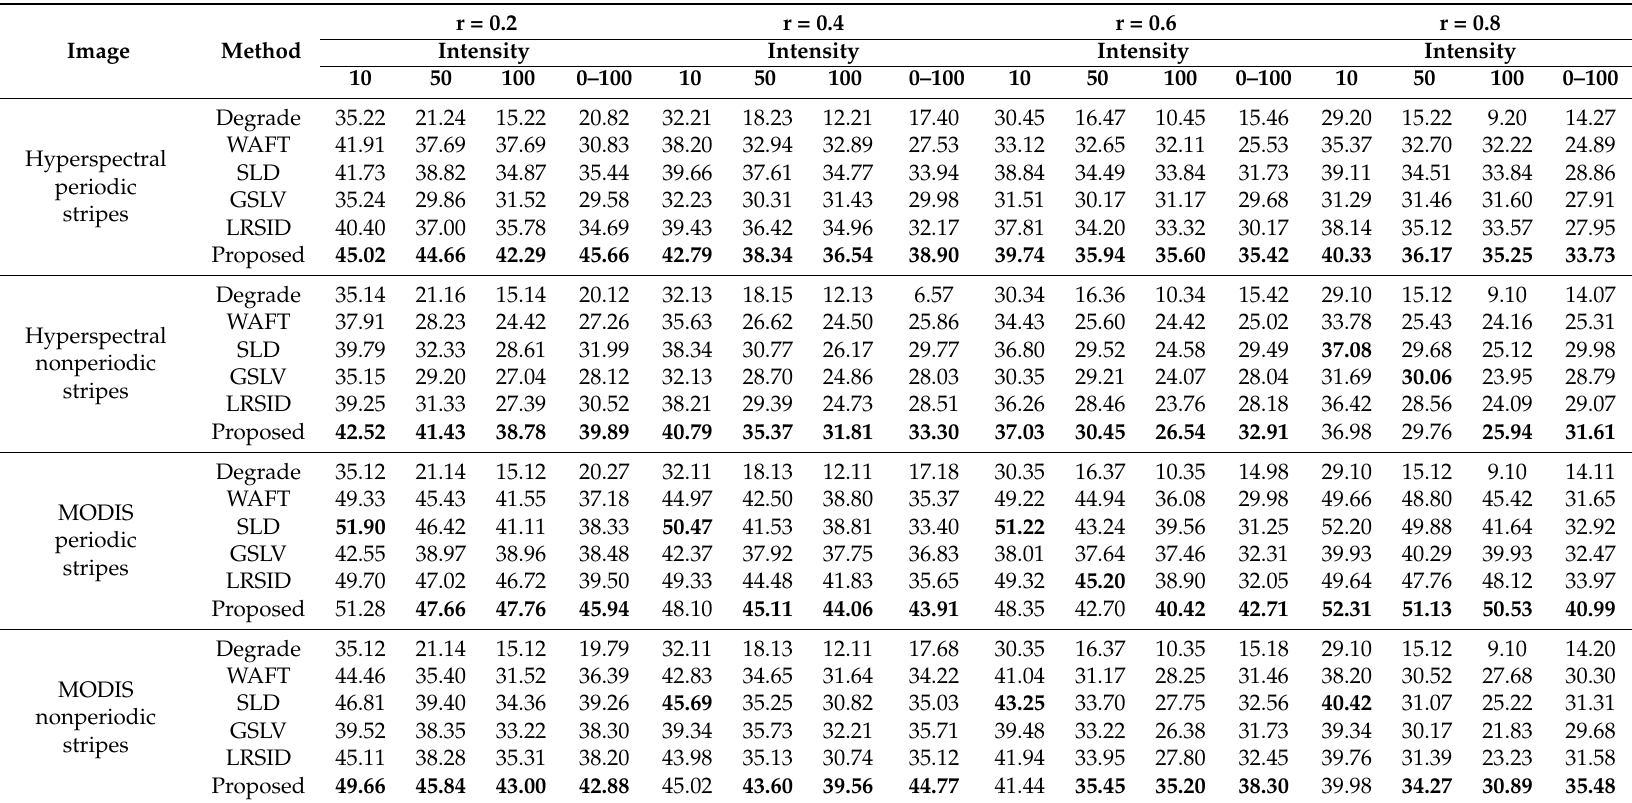
Table 1. PSNR (dB) results of the test methods for different stripe noise